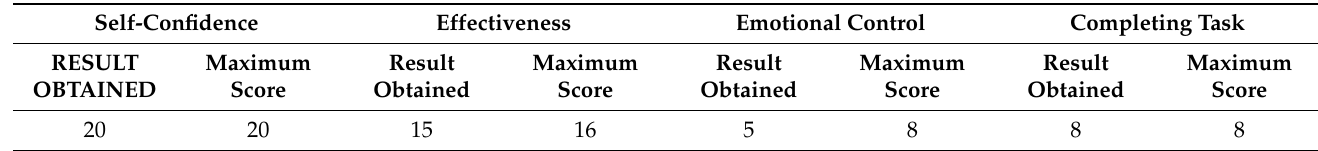
Table 13. Mental resistance variables.